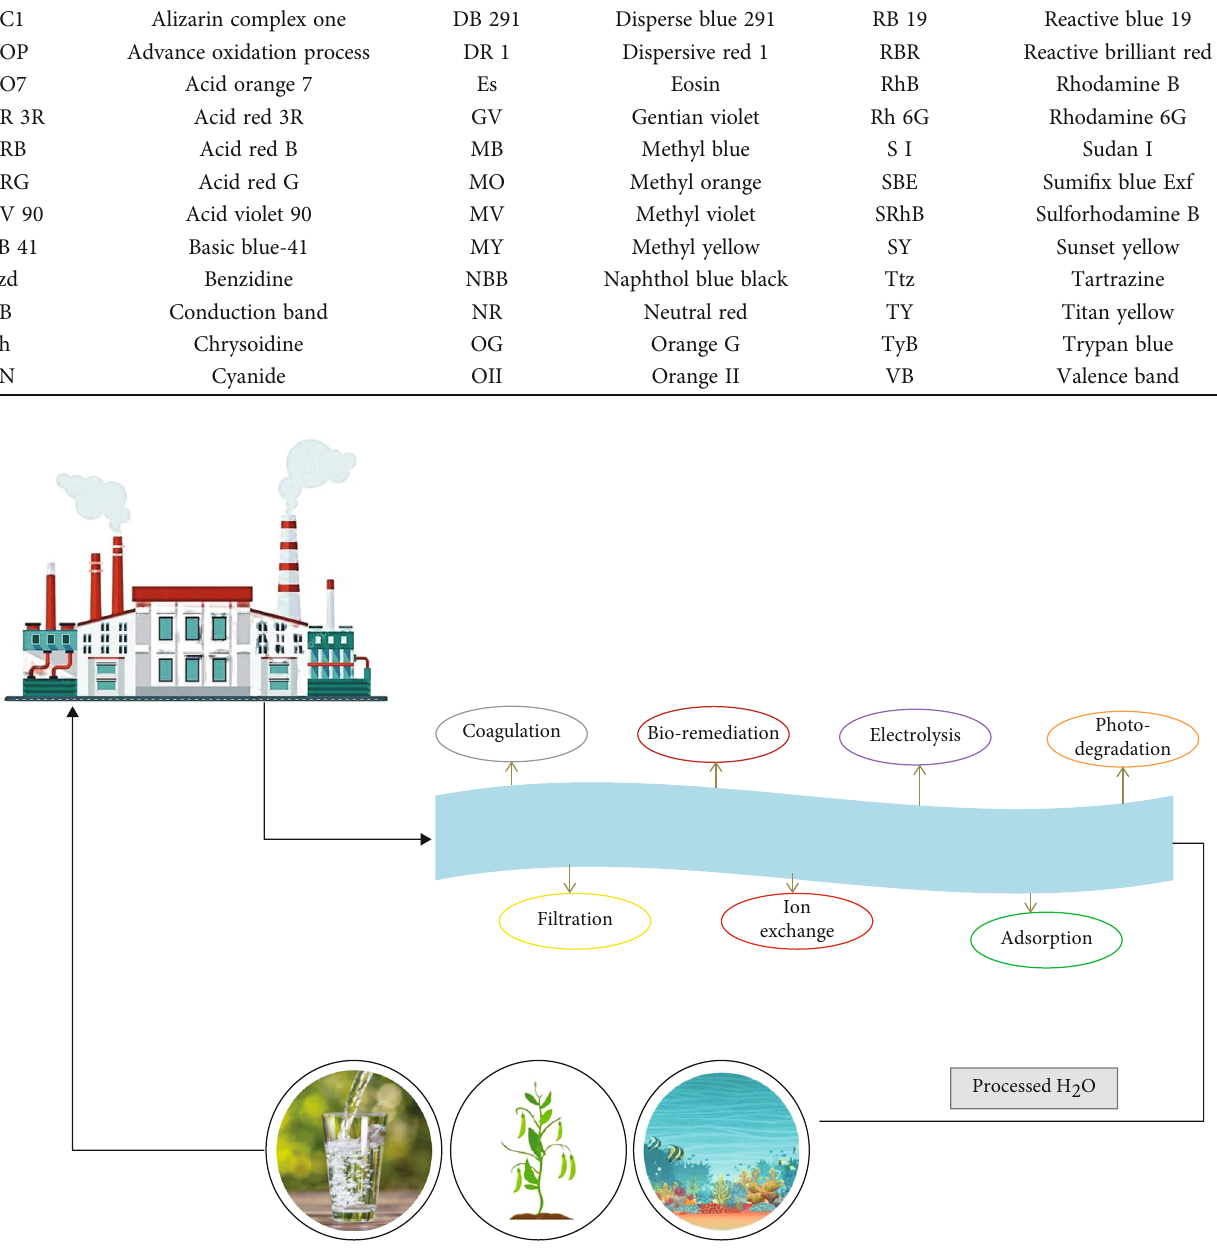
Figure 1: Schematic representation of textile waste water treatment plants.